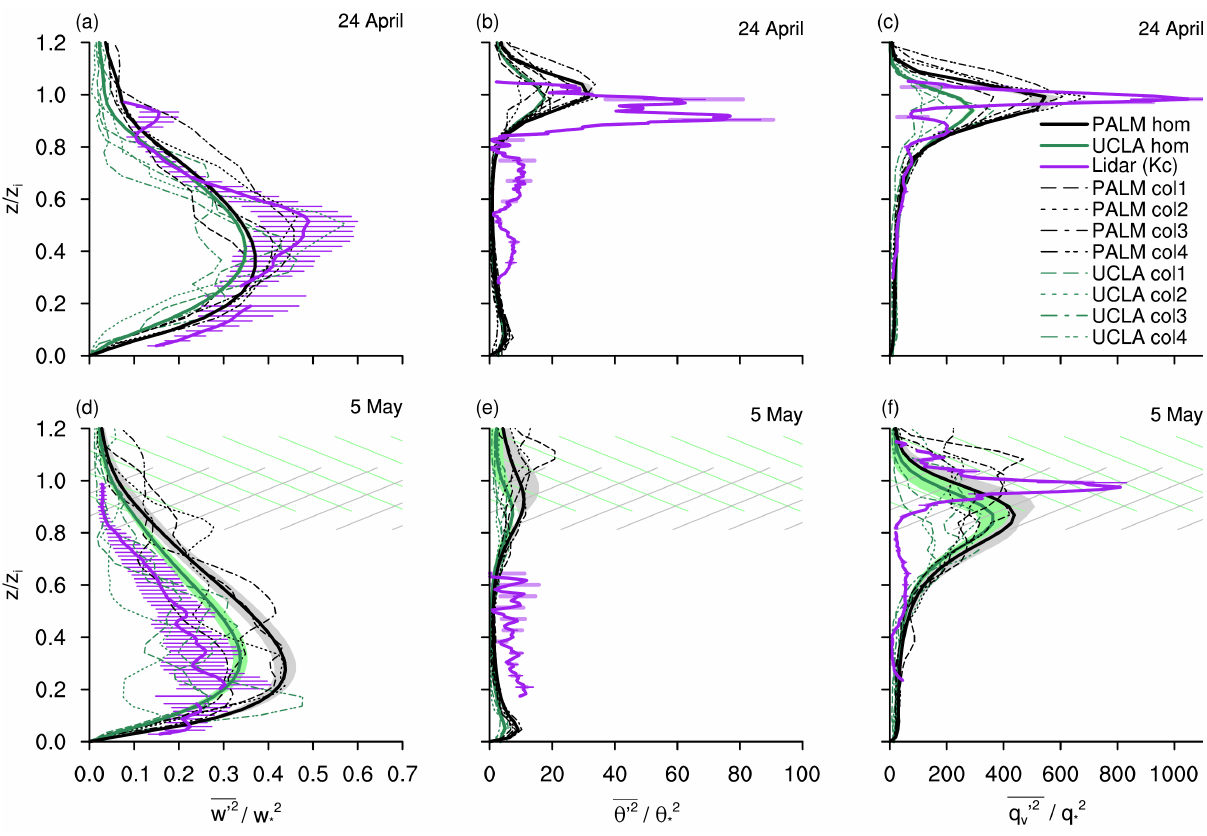
Figure 9. Normalized vertical profiles of vertical velocity variance (a, d) , potential temperature variance (b, e) and mixing ratio variance (c, f) for a 1h period between 11:00 and 12:00UTC for 24 April and 5 May 2013, respectively. Solid black and green lines show variances in PALM and UCLA-LES determined as departure from the horizontal mean ( hom ) and averaged over 1h, including standard deviations denoted as solid gray and light green areas. Thin dashed black and green lines show variances from single-column output ( colX ) at four different grid points determined as departure from a 1h temporal mean. Solid purple lines denote variances from the KIT Doppler lidar, including the statistical error according to Lenschow et al. (1994) as error bars (a, d) , the rotational Raman lidar (b, e) and the water vapor differential absorption lidar from the University of Hohenheim (c, f) , (see Table 1 for further details). The thin purple (thick light purple) error bars in (b) , (c) , (e) and (f) show the noise (sampling) error according to Lenschow et al. (2000). Gray and light green shaded regions in (d) – (f) denote the cloud boundaries of PALM and UCLA-LES, respectively. See Table 3 for the scaling values